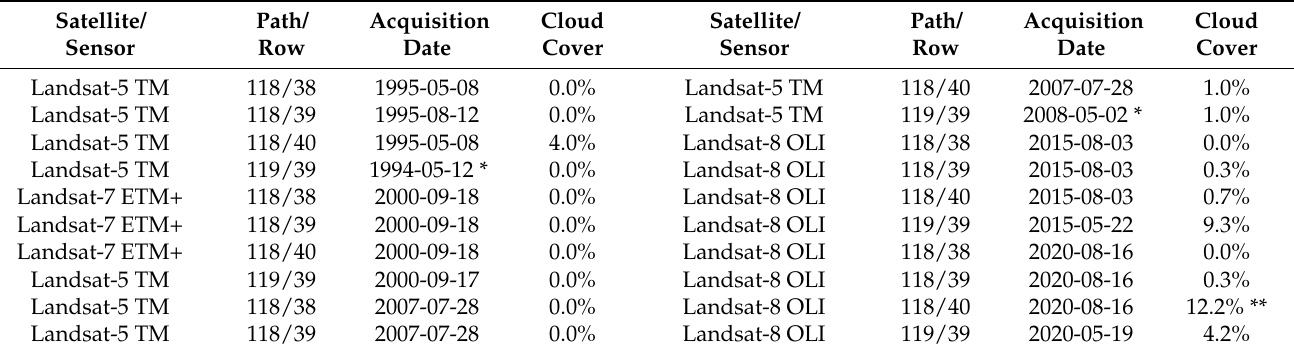
Table 1. Details for Landsat C2L2 products used in our